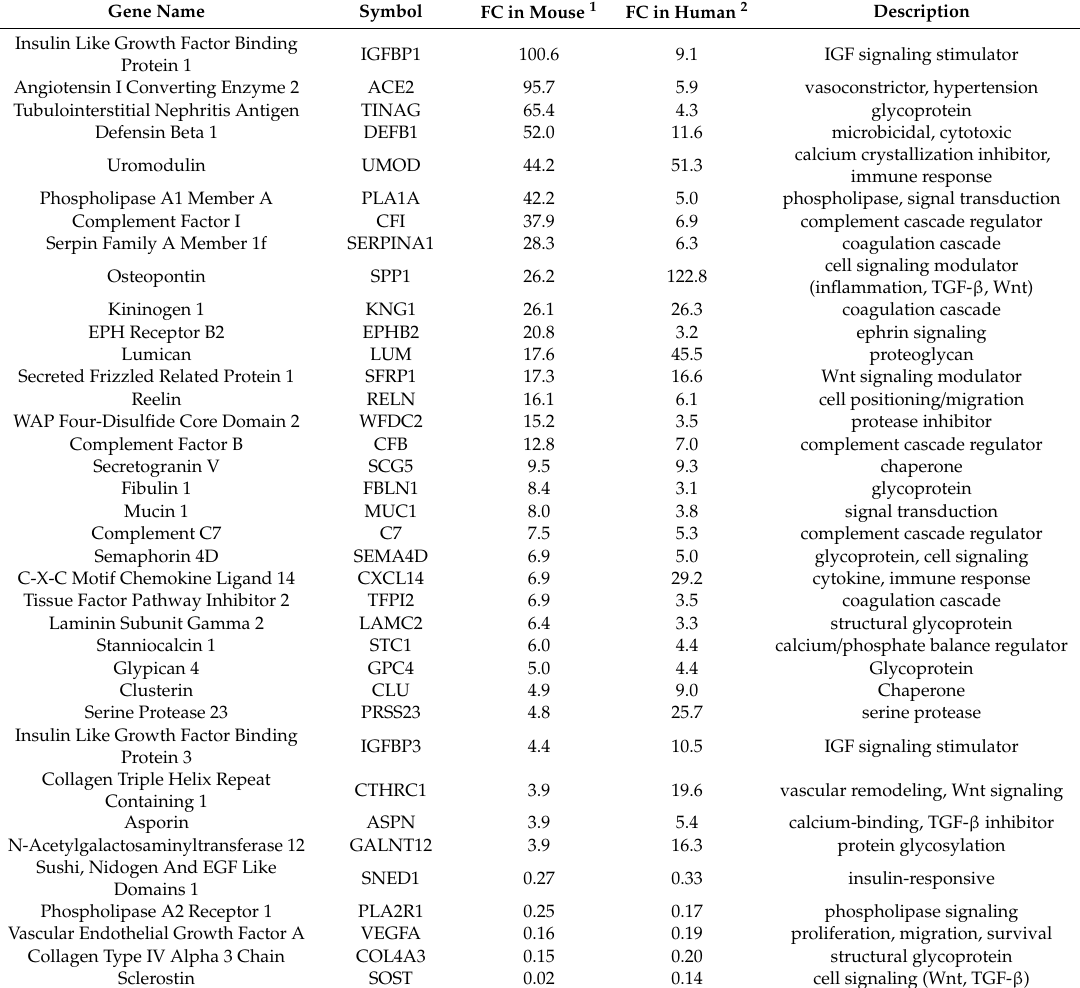
Table 2. ECM genes dysregulated in glomeruli of miR-193a-driven FSGS and FSGS patient